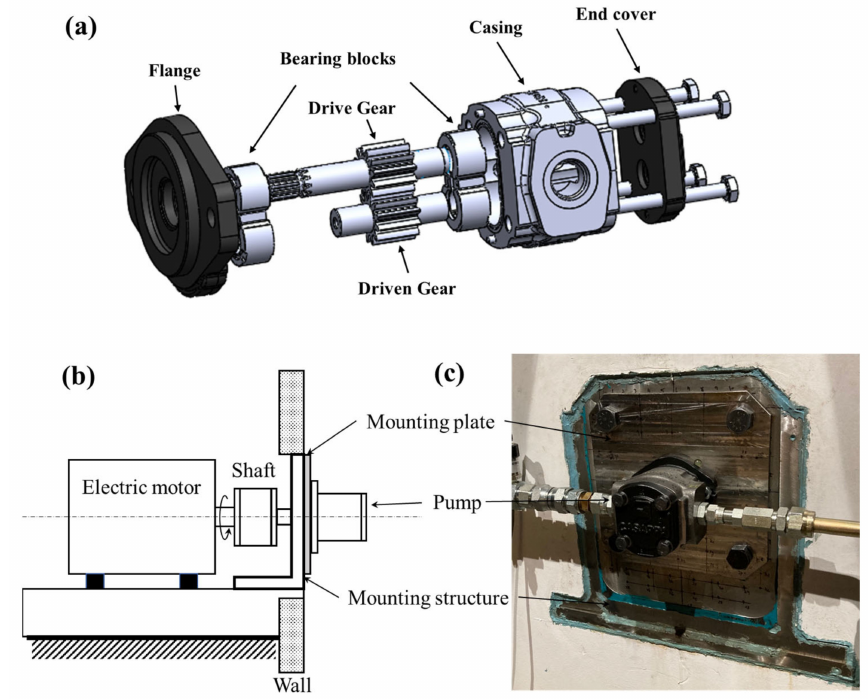
Figure 1. ( a ) Exploded view of the reference external gear pump, ( b ) schematic, and ( c ) picture of the reference unit mounted to the test